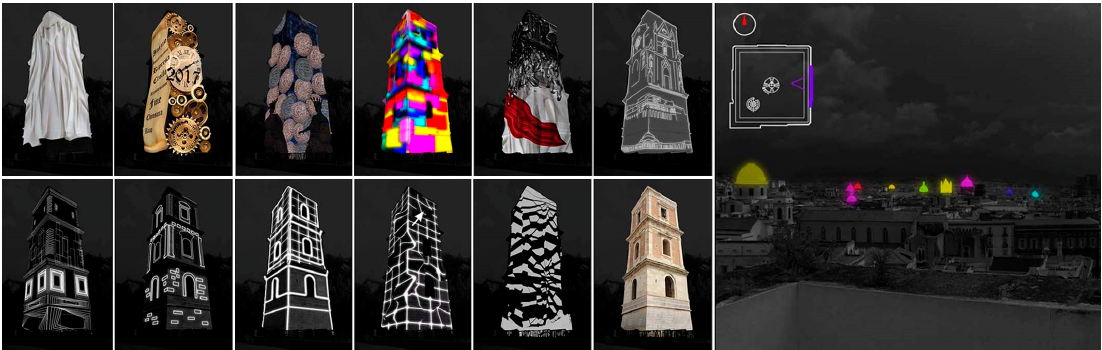
Figure 9. Santa Chiara bell tower, Il suono della luce (graphic design by Paola